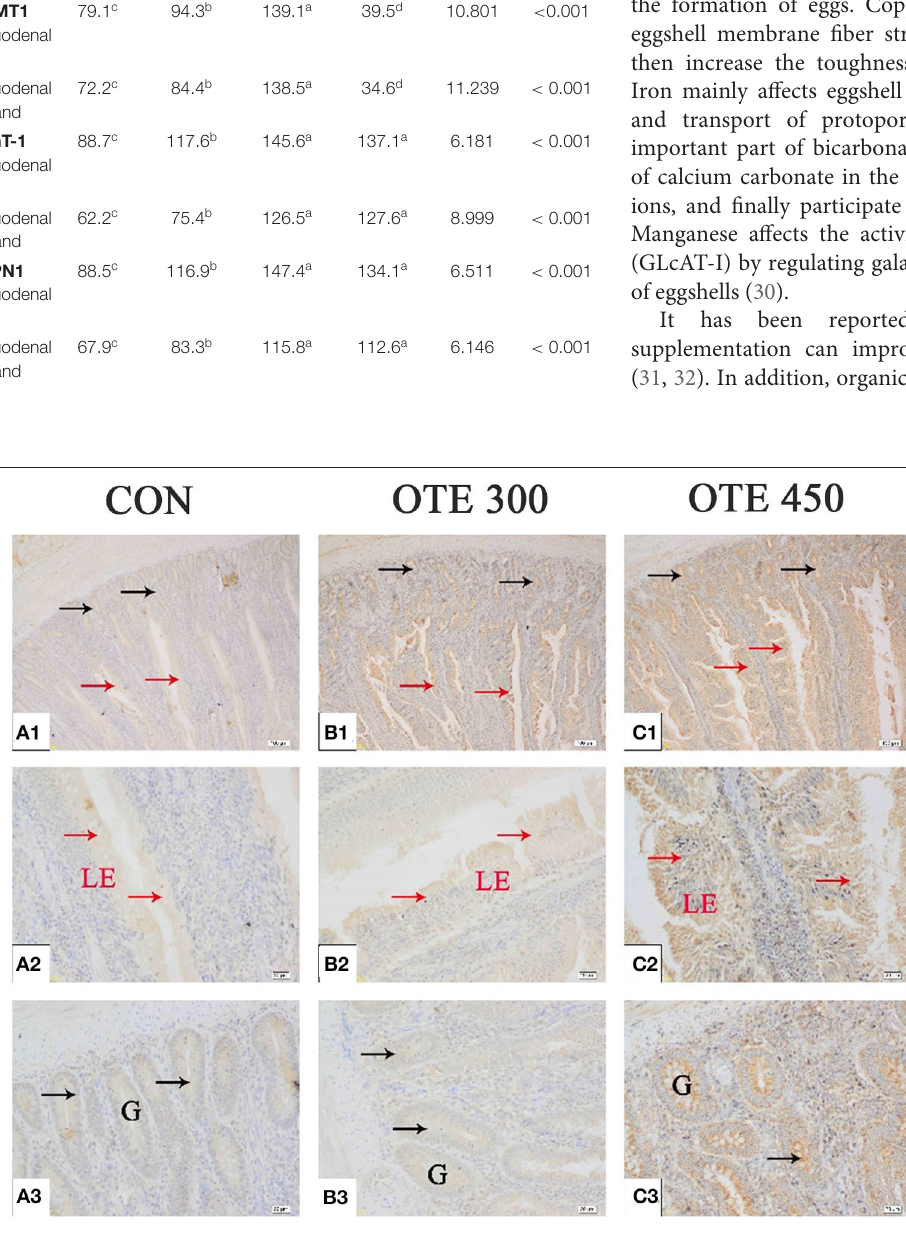
Frontiers in Veterinary Science |